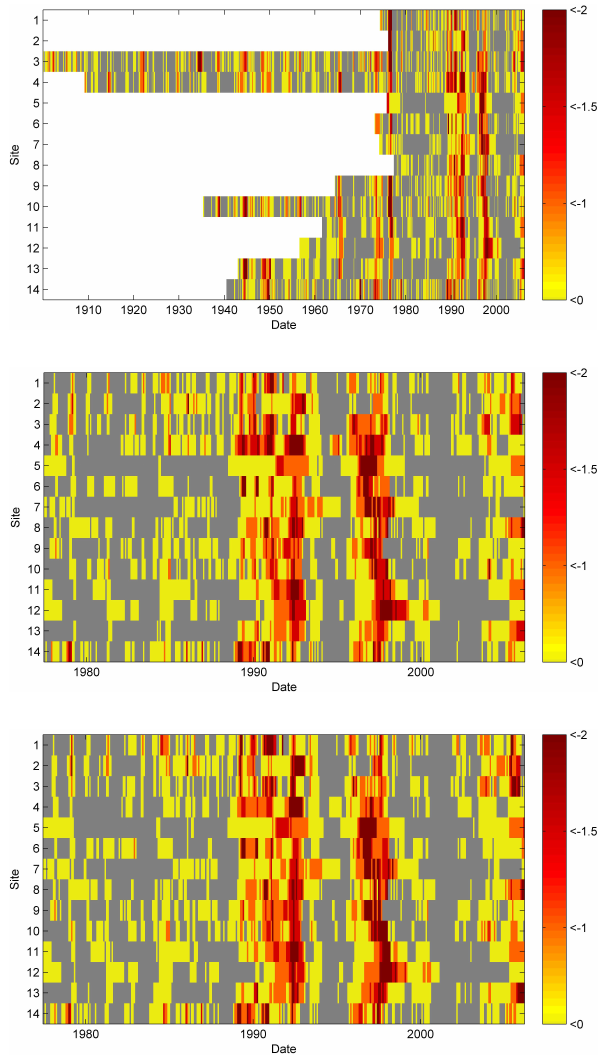
Fig. 11. (a) Monthly values of SGI for the 14 sites as heat map using for the full records, (b) SGI estimated using the full records, but just showing the last 29yr of the records, and (c) SGI estimated only using the last 29yr of the records. Sites are listed in Table 1 in alphabetical order from top to bottom. SGI is colour coded from 0 to − 2, periods of positive SGI equating to non-drought conditions are in grey.